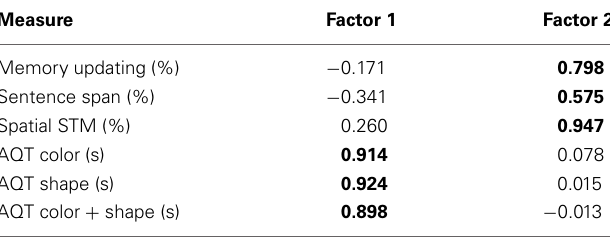
Table 4 | Component weights from the pattern matrix for each cognitive measure on each of the two oblique principal components identified via factor analysis.